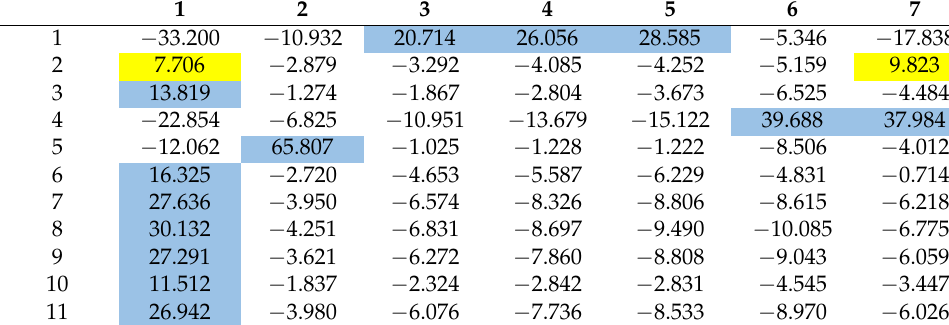
Table A8. Theoretical frequencies DRF 2012